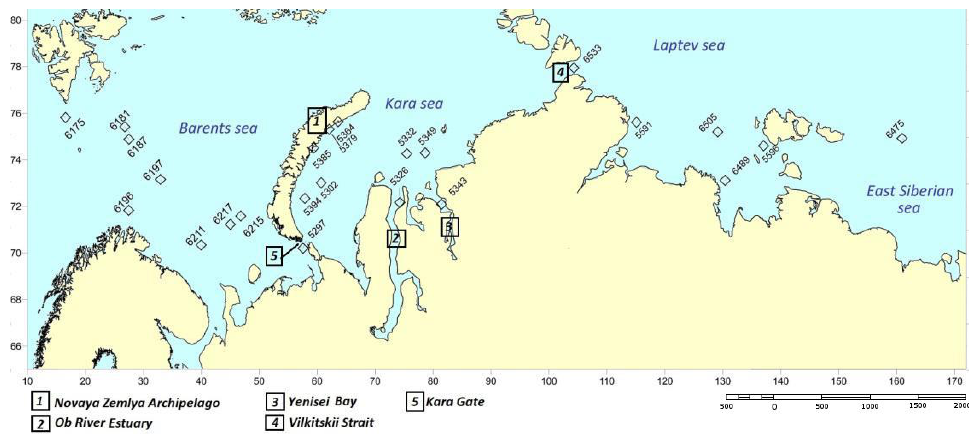
Figure 1. The sampling stations location of surface bottom sediments from the Arctic seas.